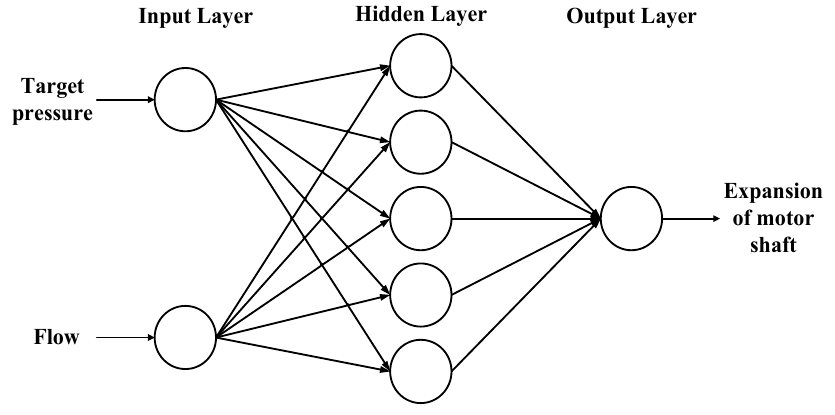
Figure 4. Neural network model.